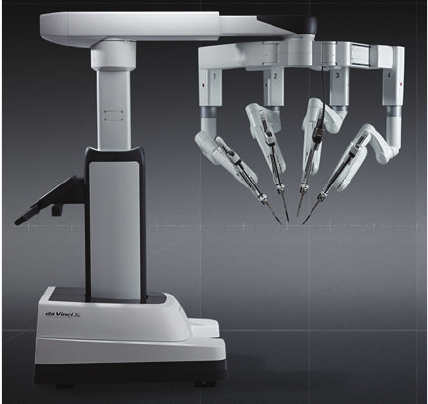
Figure 1: Da Vinci Xi patient cart.